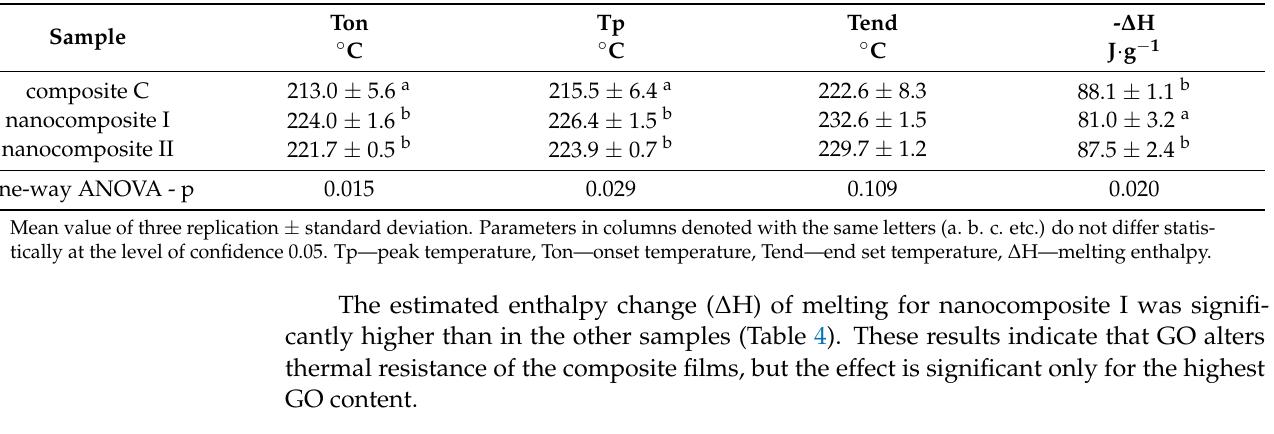
Table 4. Parameters of melting peak